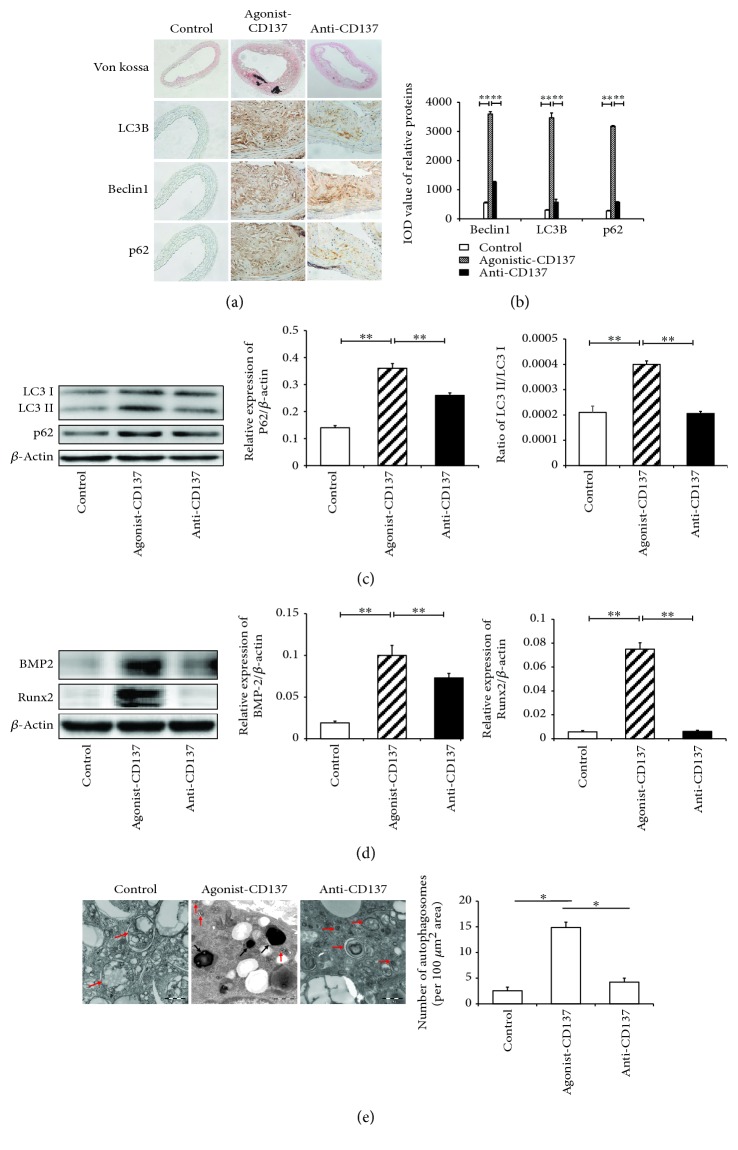
CD137 signaling activation induced calcification and autophagy in ApoE−/− mice. (a, b) Von Kossa staining of calcification region and immunohistochemistry staining of Beclin1, LC3B, and p62 in the aorta of ApoE−/− mice. (c, d) The expression of LC3, p62, and calcification-associated proteins (BMP2, RUNX2) in the aorta of ApoE−/− mice was detected by Western blot. (e) Transmission electron microscopy was used to trace autophagosomes in aortic plaque of ApoE−/− mice (red arrow: autophagosomes; black arrow: calcium deposition). Data are expressed as the mean ± SEM of at least three independent experiments. ∗ refers to P < 0.05; ∗∗ refers to P < 0.01.